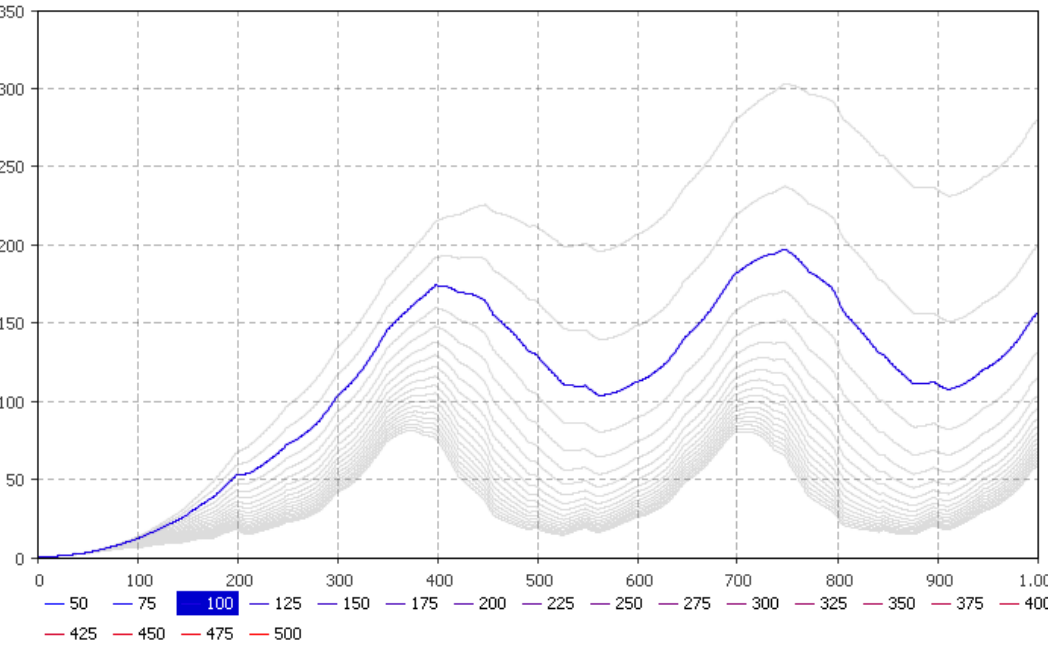
Figure 12. Parameter variation experiment estimating the RAS ‐ derived N ‐ NO 3 concentration in mg/L ( y ‐ axis) based on different cultivation area (m 2 ) options under natural light conditions. The days are displayed on the x ‐ axis. It can be seen that 200 mg/L N ‐ NO 3 are not exceeded, when having 100 m 2 cultivation area.